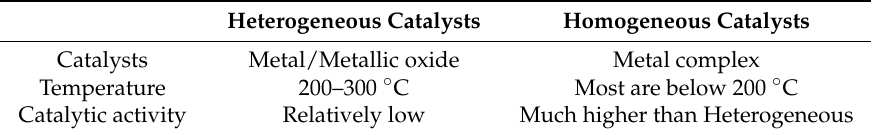
Table 1. The comparison of catalysts for CO 2 to methanol hydrogenation reaction.